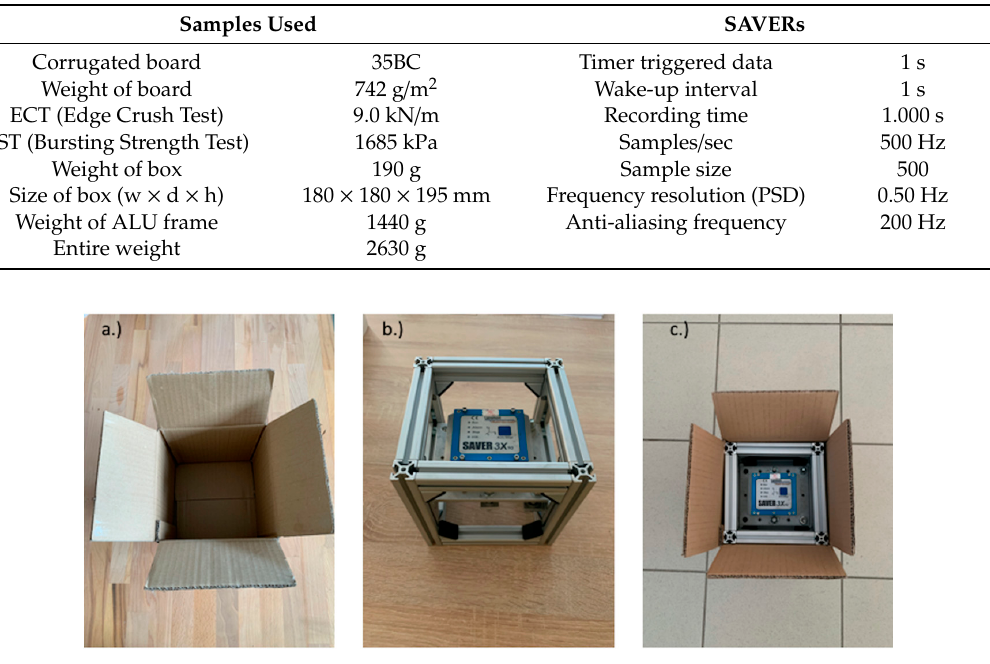
Figure 2. ( a ) Corrugated box, ( b ) aluminum profile, and ( c ) test sample used for this